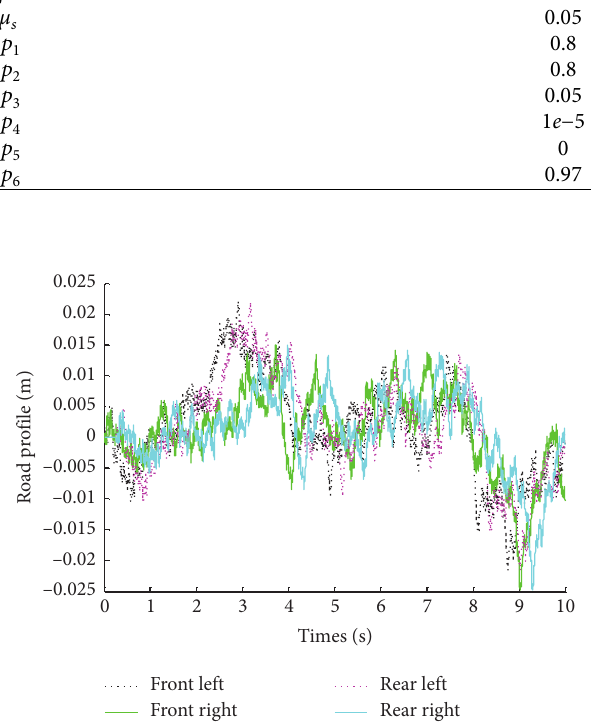
Figure 4: Four-wheel excitation input.